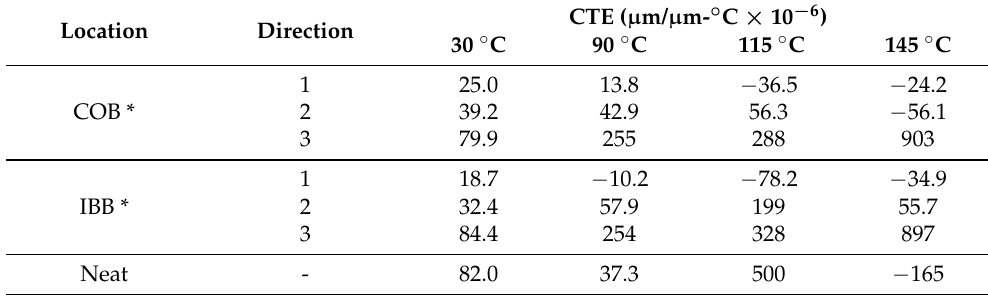
Table 6. CTE values for CF/ABS and ABS ( T g = 104–108 ◦ C).